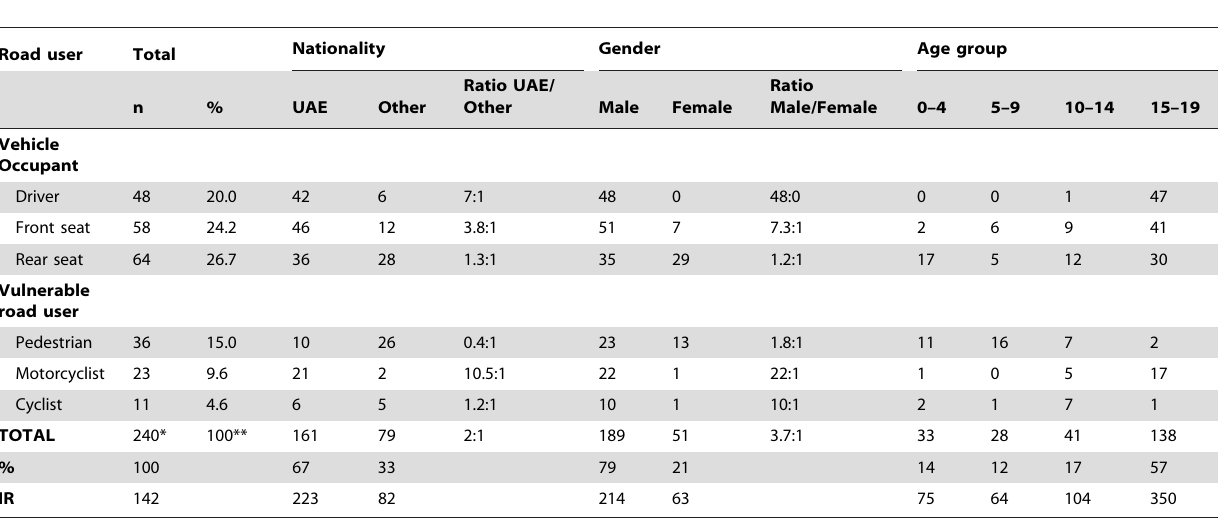
Table 1. Traffic-related injury hospitalisations by road user type, nationality, gender and age group, Al Ain, 2006–2007 (n=245).